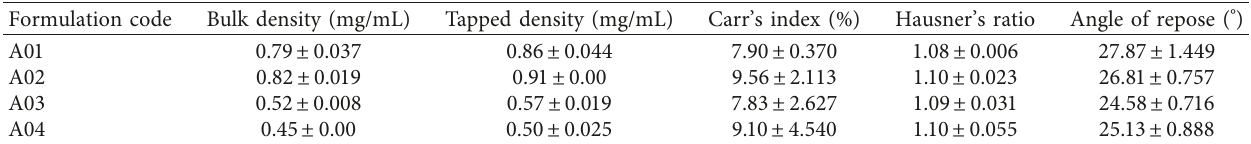
Table 2: Flow properties of Antiaris africana granules ( n �